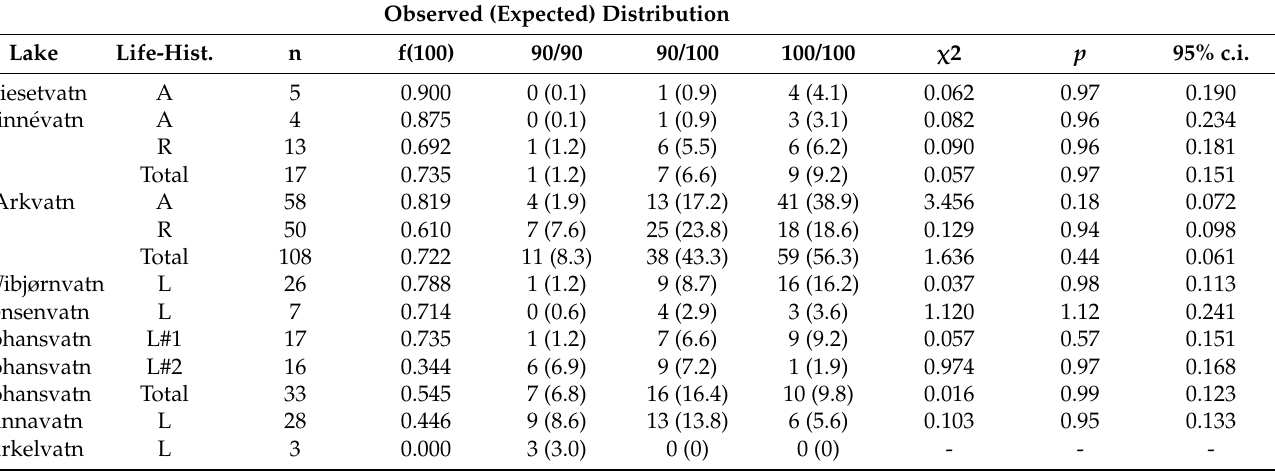
- - Table 3. Observed allele and genotype frequencies, their expected genotype distribution (in paren- theses), deviation from the Castle–Hardy–Weinberg proportions, and the 95% confidence interval at the EST-2* locus in different sex and age groups of anadromous/resident Arctic char from Lake Arkvatn, Svalbard. Age and Sex Groups